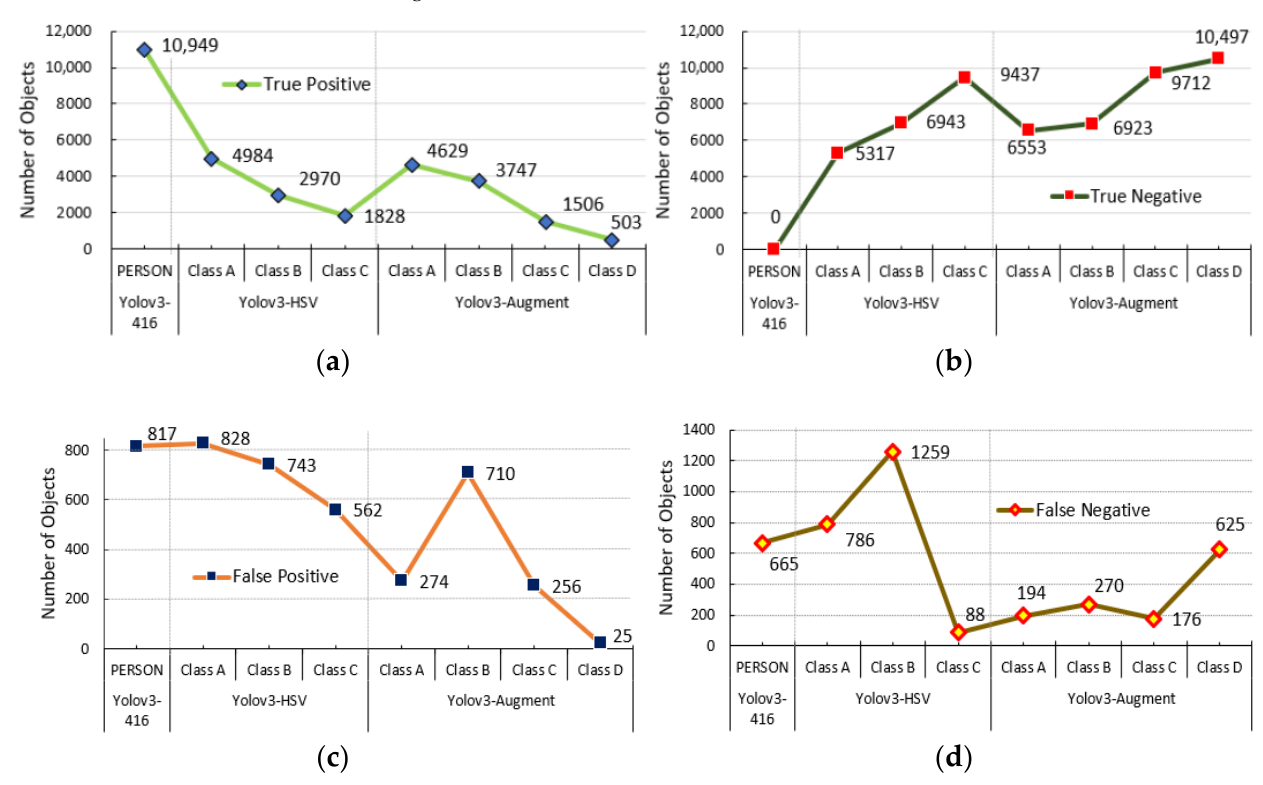
Figure 15. Object recognition results: ( a ) True Positive results; ( b ) True Negative results; ( c ) False Positive results; ( d ) False Negative results.